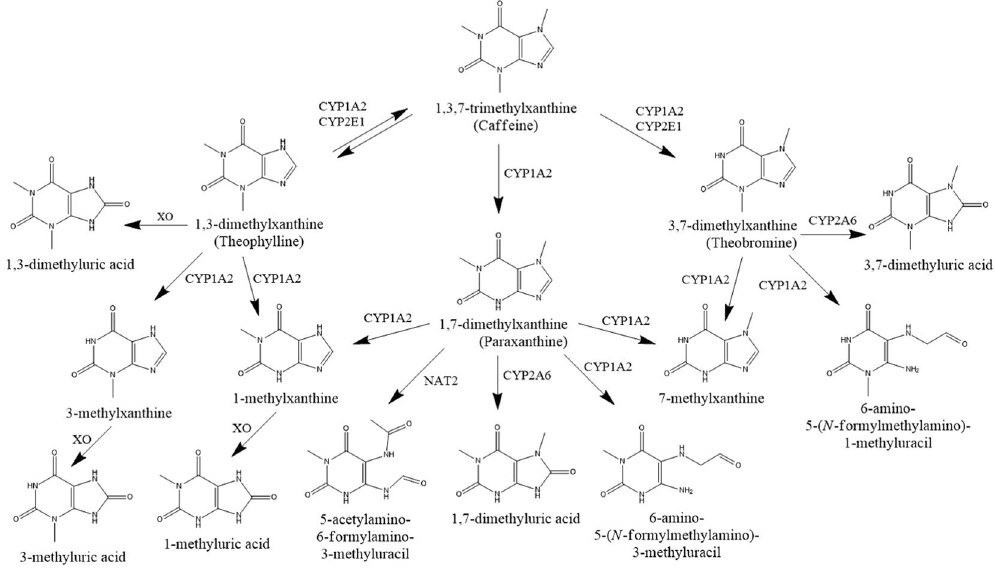
Figure 1. Biotransformation of methylxanthines 9 .